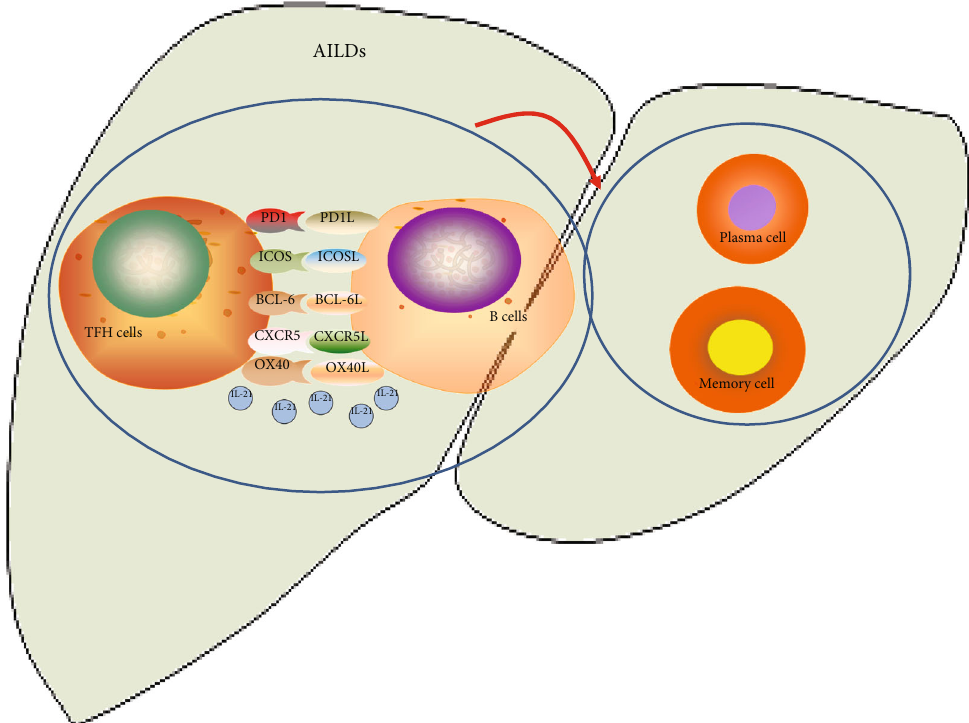
Figure 1: AILDs: autoimmune liver diseases; PD-1: programmed cell death protein-1; CXCR5: CXC chemokine receptor 5; ICOS: inducible T cell costimulator; IL-21: cytokine interleukin- (IL-) 21; BCL-6: B cell lymphoma 6; OX40: tumor necrosis factor receptor. TFH plays a key role in assisting B cells. Autoimmune diseases are characterized by excessive activation of B cells, leading to the production of autoantibodies and attacking their normal tissues. This suggests that TFH cells may have an important in fl uence on the pathogenesis of autoimmune